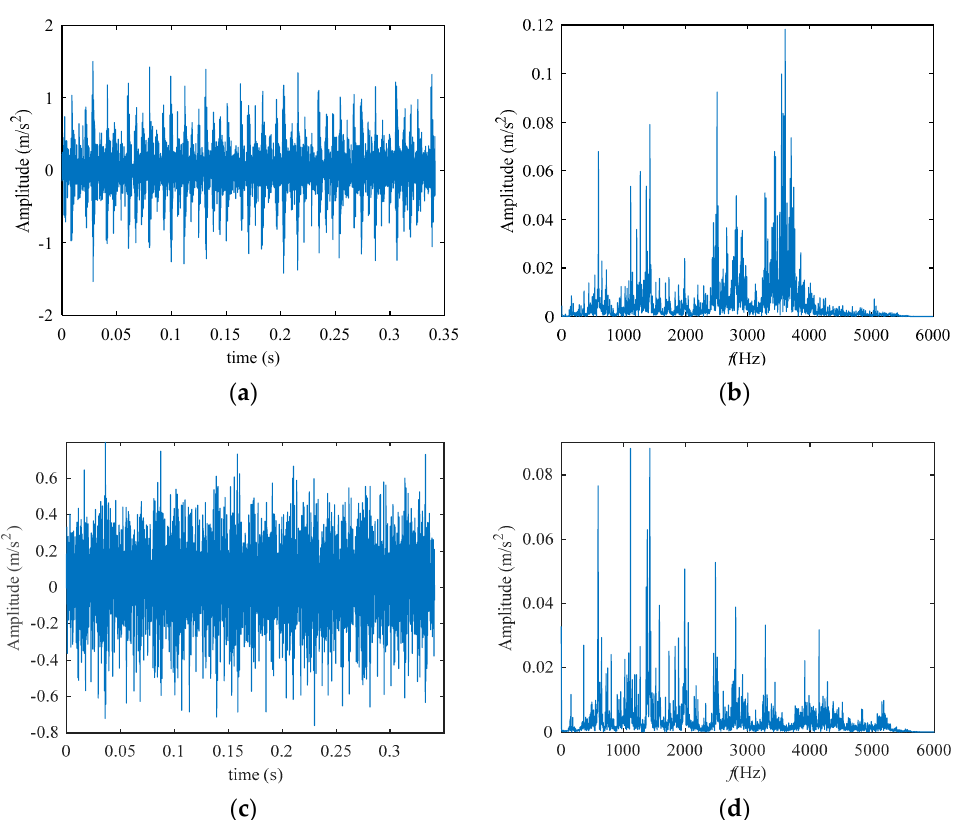
Figure 14. The 108th data of the database. ( a ) Time-domain waveform of the original signal at the drive end. ( b ) Frequency spectrum of the original signal at the drive end. ( c ) Time-domain waveform of the original signal at the fan end. ( d ) Frequency spectrum of the original signal at the fan end. SVD is applied to the original signal, and the difference spectrum is shown in Figure